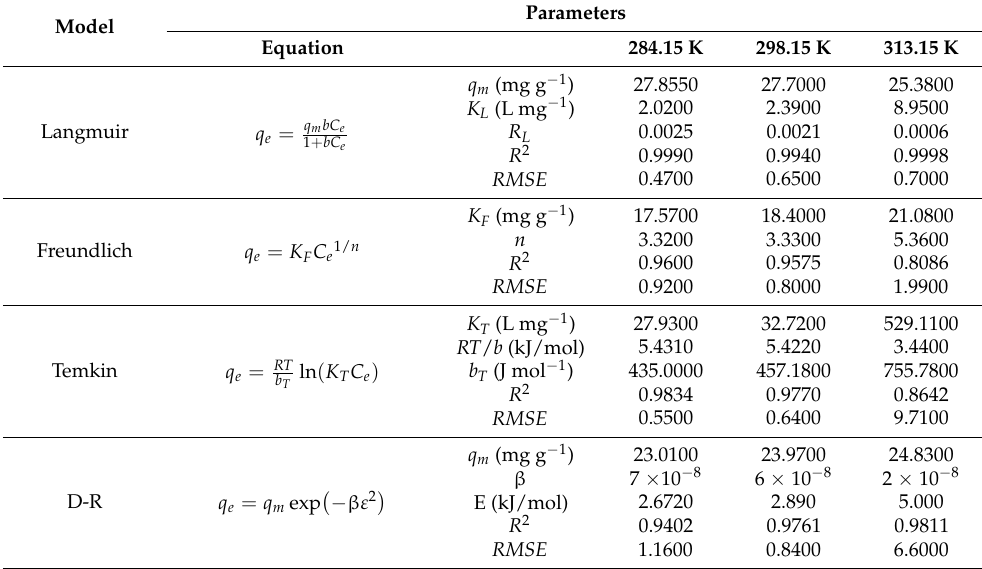
Table 2. Isotherm parameters for the adsorption of MV onto HNC.